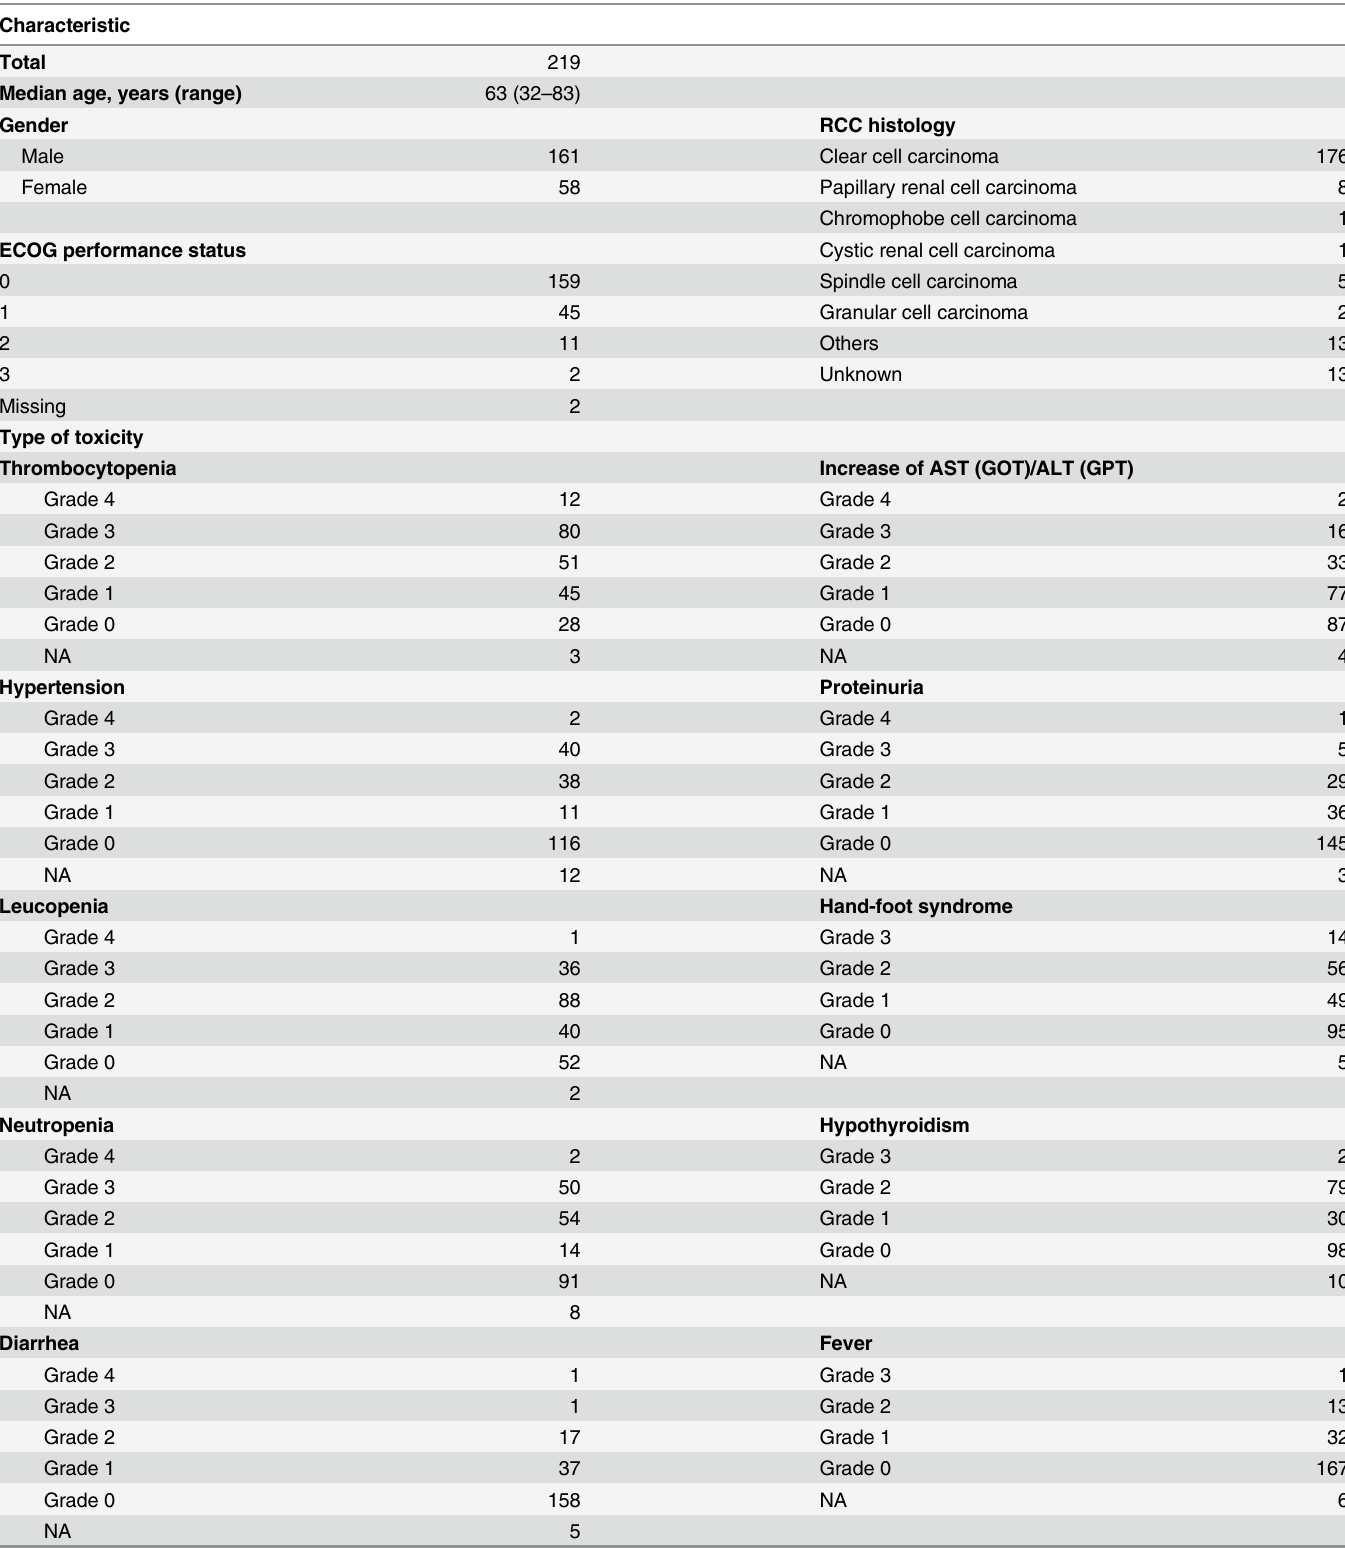
Table 1. Patient demographics and toxicity grades of this